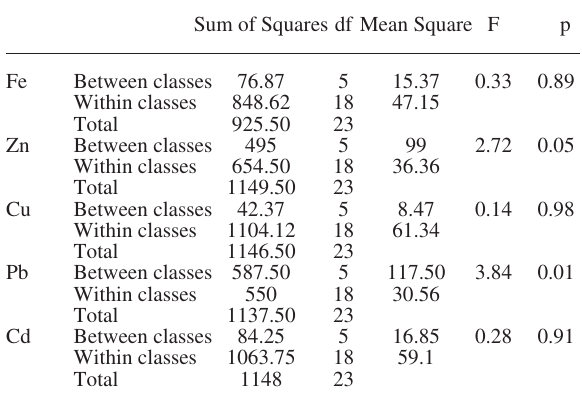
Fig . 6. – Multidimensional scaling (MDs) - two-dimensional map - of the metal composition in each wet weigh class along Águas de Moura channel (stress =3e -2 ; rsQ =0.99). letters refer to the sampling site and numbers (1 – 6) refer to the weight classes. Table 7. – test null hypothesis of equal population covariance matrices in the two methods used: Wilks’ lambda ( ∧ ) and the Maha-